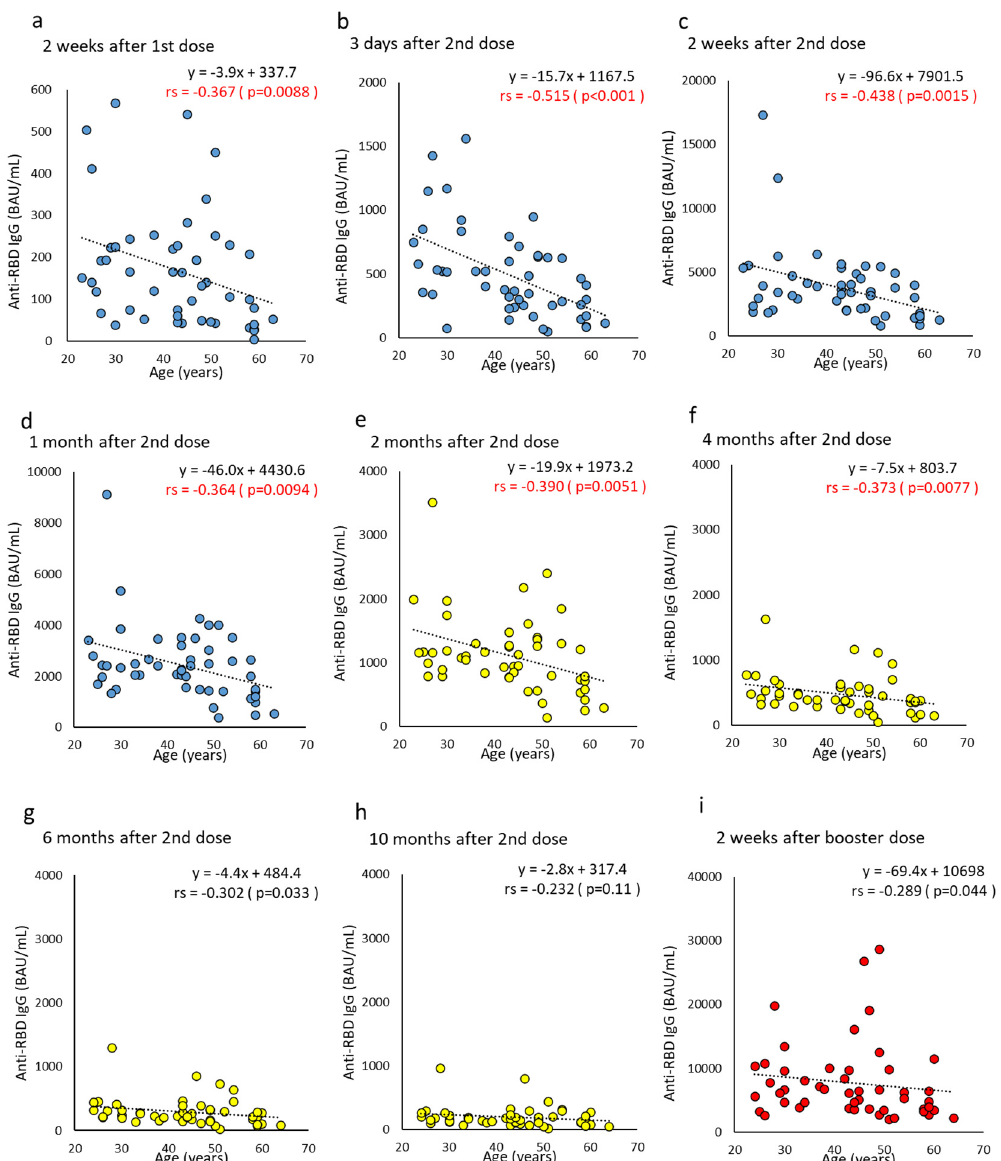
Figure 3. ( a – i ). Correlation at time points between age and anti-RBD IgG after BNT162b2 vaccine doses. Parameter levels indicating anti-RBD IgG of humoral immunity against SARS-CoV-2 are plotted and compared according to age at each time point post-vaccine doses. Time points until one month after two doses are colored blue ( a – d ), from two months to 10 months after two doses are colored yellow ( e – h ), and two weeks after the booster dose are colored red ( i ). p -values were calculated using Spearman’s rank correlation test and significance was set at 0.01. Red values indicate a significant correlation (rs, Spearman’s rank correlation coefficient).